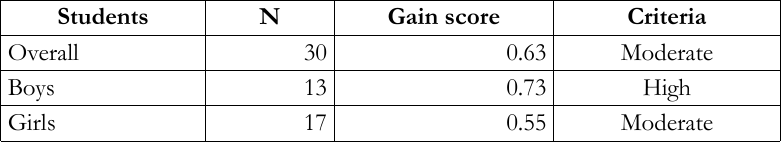
Table 2. Gain score obtained between boys and